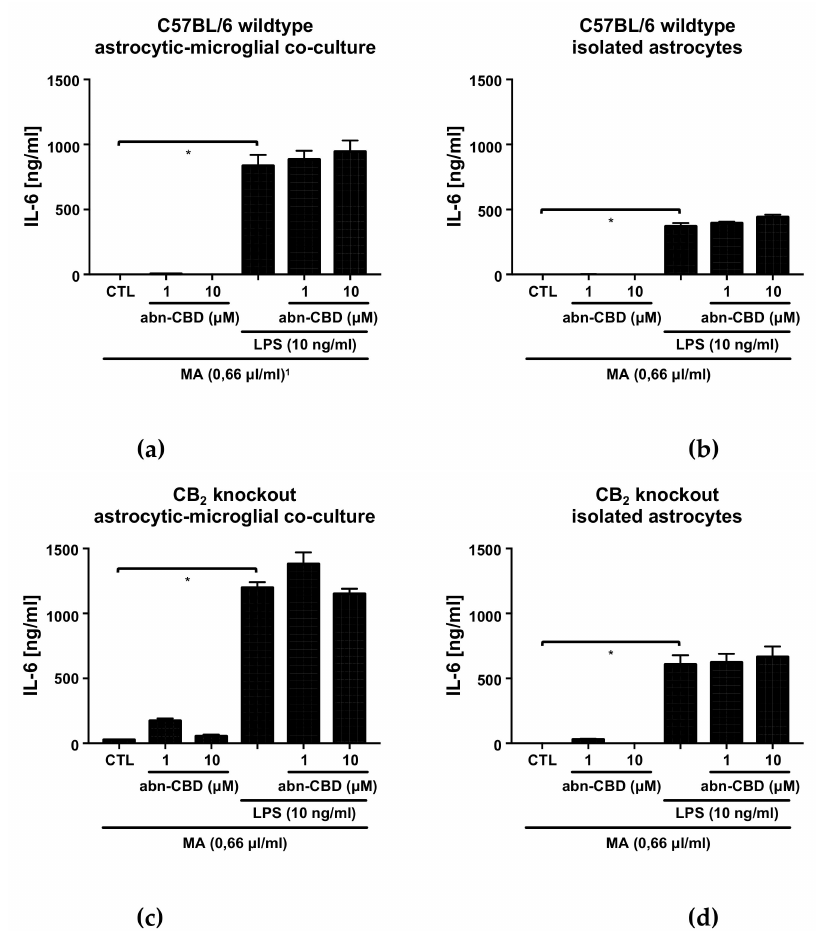
Figure 3. IL-6 measurement in supernatants from astrocytic-microglial cocultures ( a , c ) and isolated astrocytes ( b , d ) from C57BL / 6 wildtype ( a , b ) and CB 2 knockout mice ( c , d ). Data is expressed as mean ± SEM, n = 8 in ( a , b ) and 4 in ( c , d ). Statistical analysis was done using one-way ANOVA followed by Bonferroni’s post-test. * p < 0.05. 1 All groups received the same concentration (0.66 µ L / mL) of the solvent methylacetate (MA) as contained in 10 µ M abn-CBD